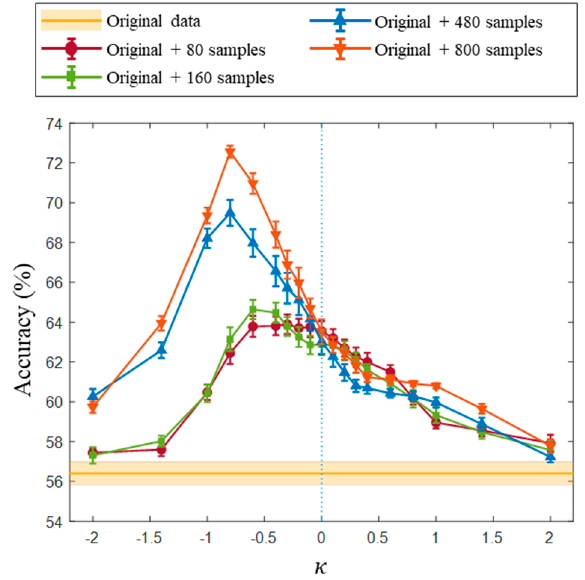
Figure 12. Classification accuracy of EMG data with GNDv2; the symbols and error bars represent the average accuracy and standard error, respectively.